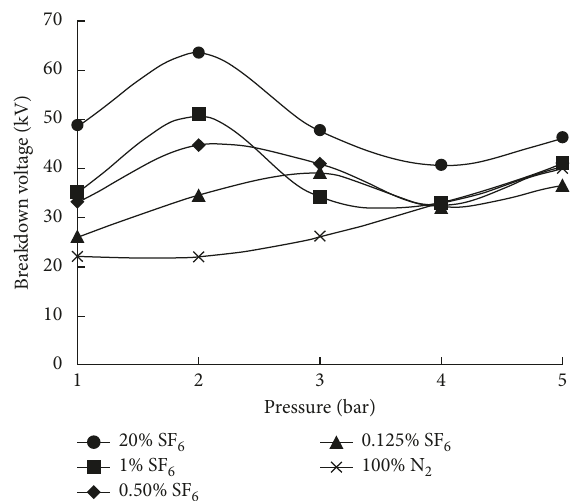
Figure 4: Changing of breakdown voltage with gas pressure for SF 6 -N 2 mixtures.